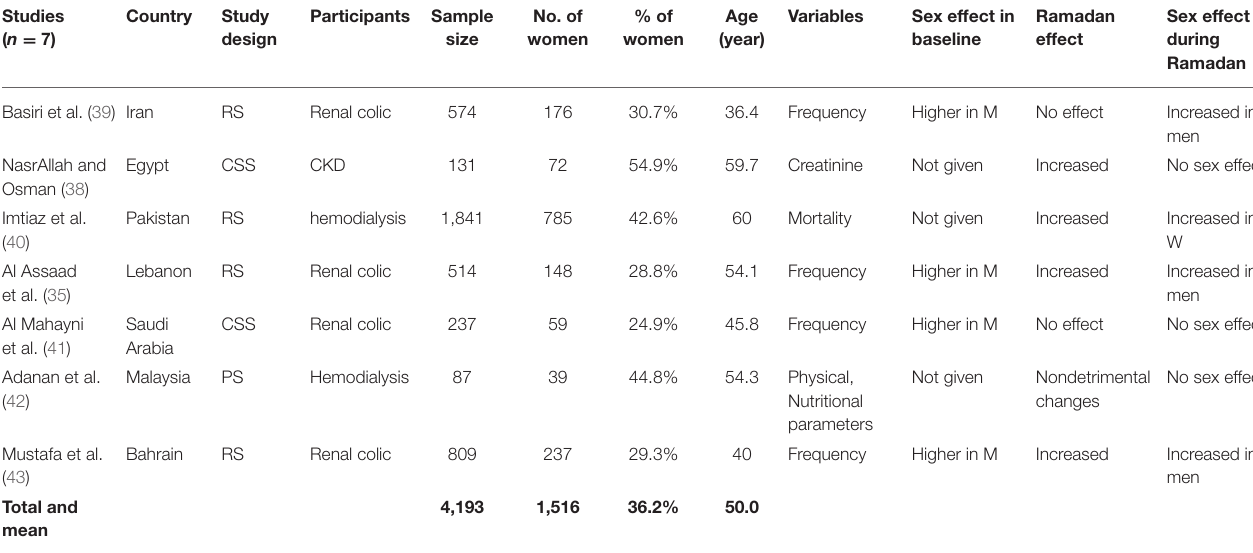
TABLE 4 | Sex differences in outcomes related to renal diseases in patients during and outside the month of Ramadan. Studies ( n =